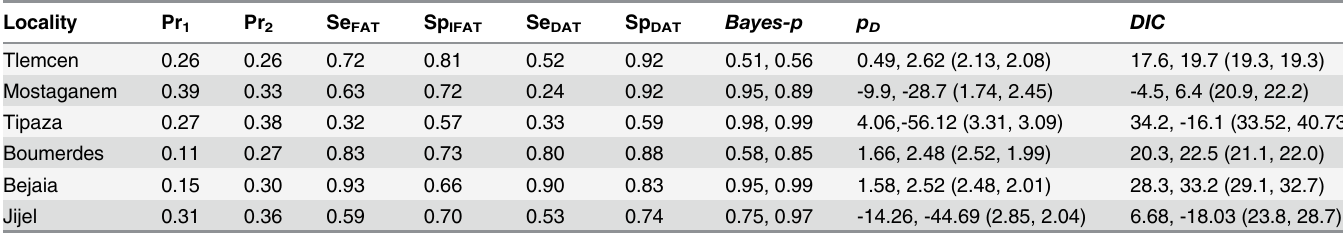
Table 5. Estimates from the Hui-Walter